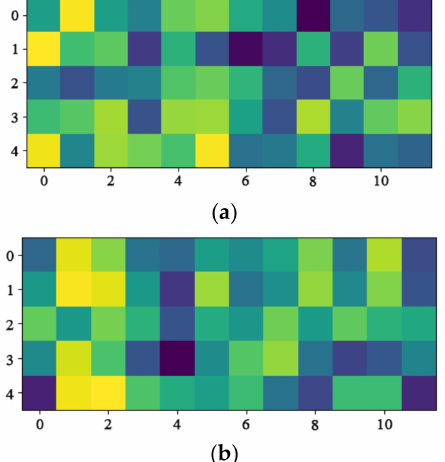
Figure 12. The visualization of convolution kernels in the first convolutional layer. ( a ) Kernel 1 ( b ) Kernel